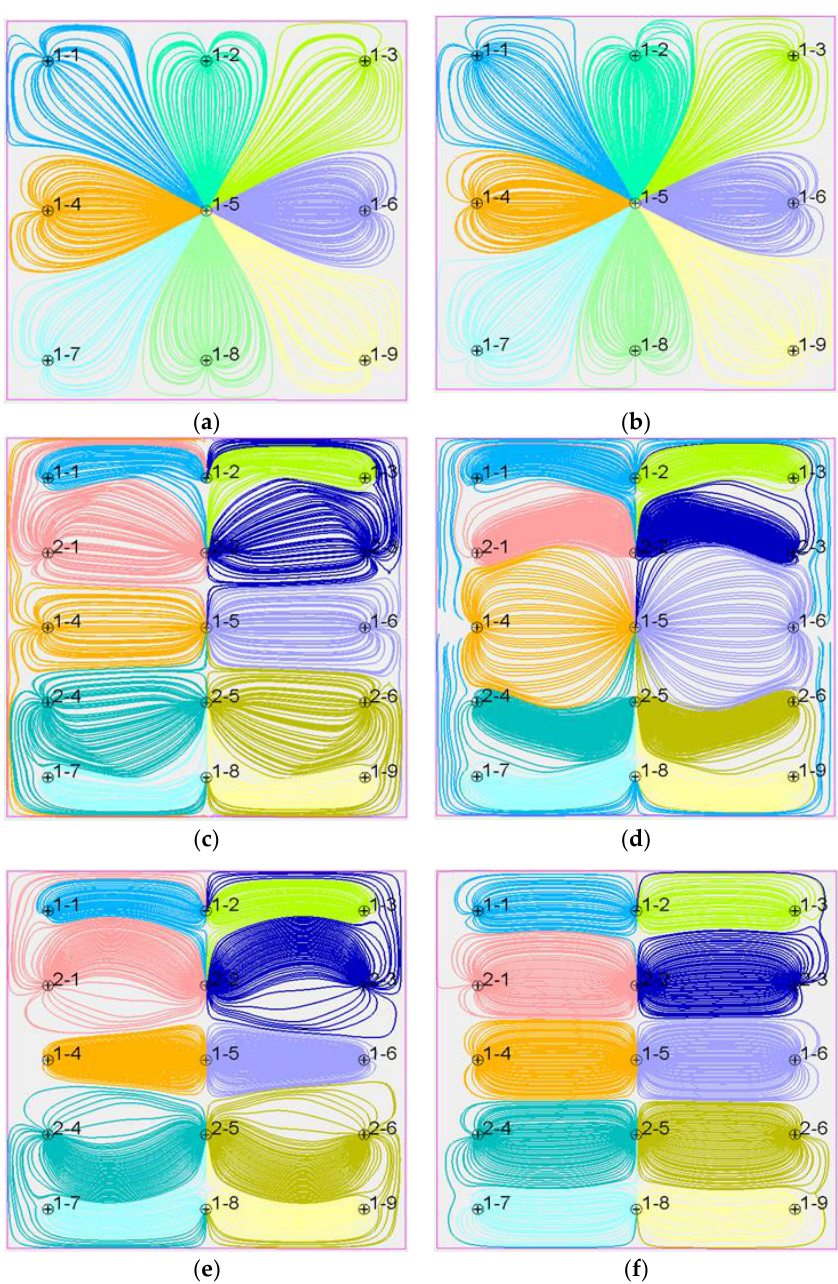
Figure 5. The change law of the streamline field in the model of the ( a ) water flooding stage, ( b ) polymer flooding stage, ( c ) injection of polymer, 0.1 PV of water / polymer flooding, ( d ) injection of polymer, 0.2 PV of water / polymer flooding, ( e ) injection of water, 0.1 PV of subsequent water flooding, and ( f ) injection of water, 0.2 PV of subsequent water flooding.